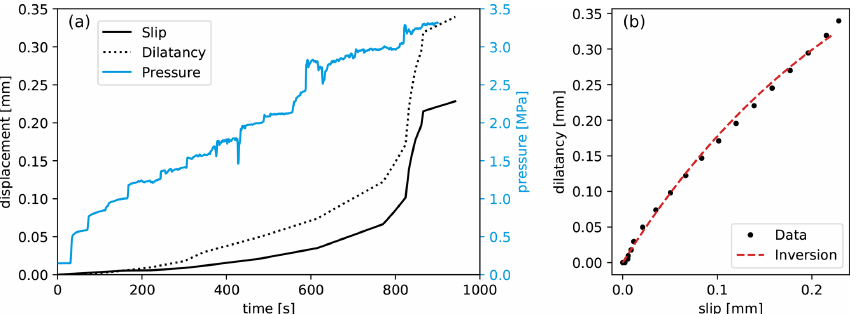
Figure 5. (a) Measurements of fault shear and normal displacement and fluid pressure during the field injection test of Cappa et al. (2019); (b) inversion of the dilatancy measured during the field injection experiment. To produce a reasonable fit to the data, an unrealistically high value of the dilatancy parameter H = 6 . 4 was required.